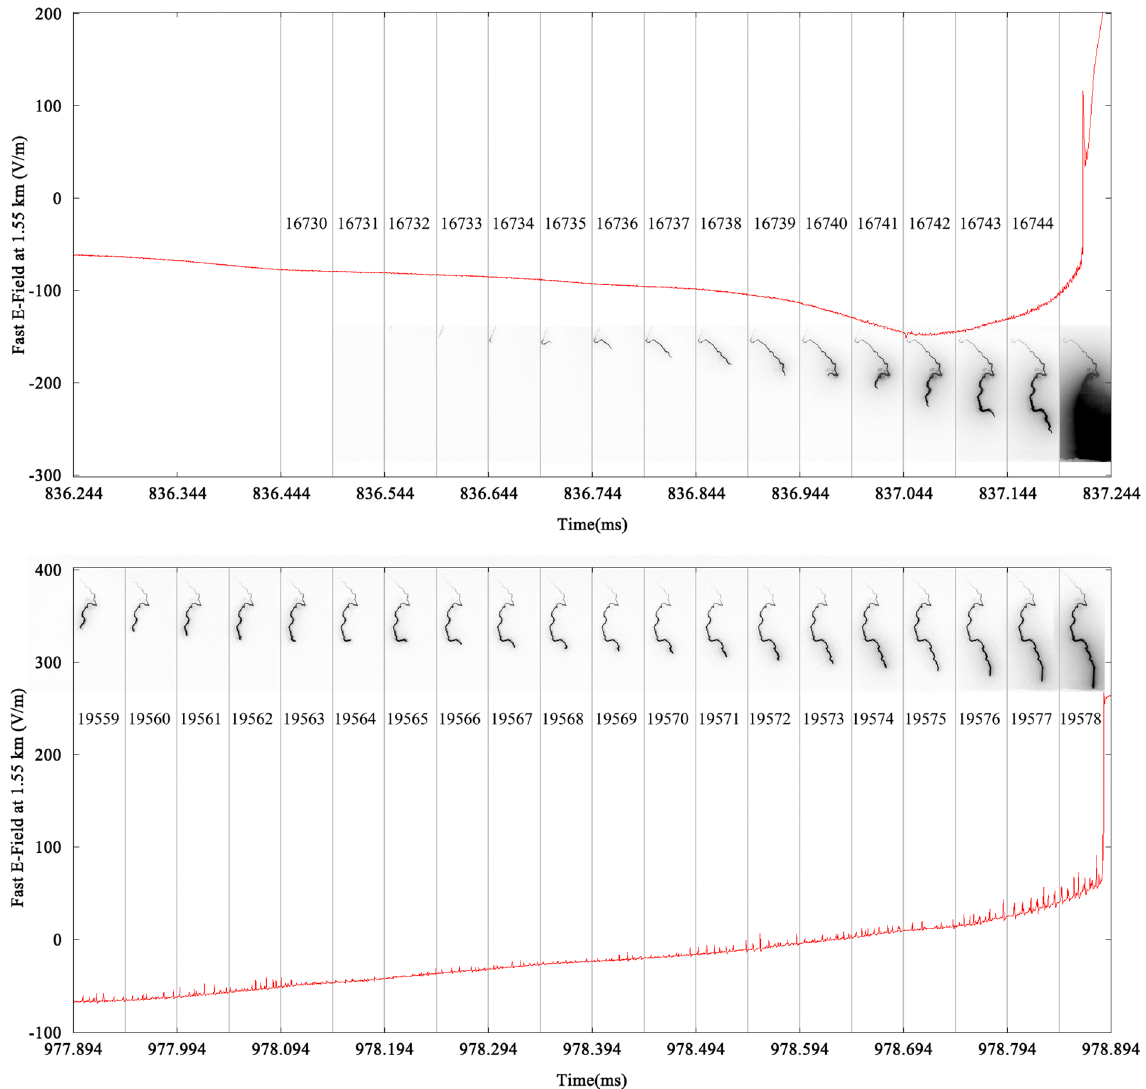
Figure 5. The electric field changes of DL13 (top) and DL14 (bottom) with corresponding high-speed frames. The waveform is separated by several grey vertical lines representing these 1 μs dead times to match high-speed